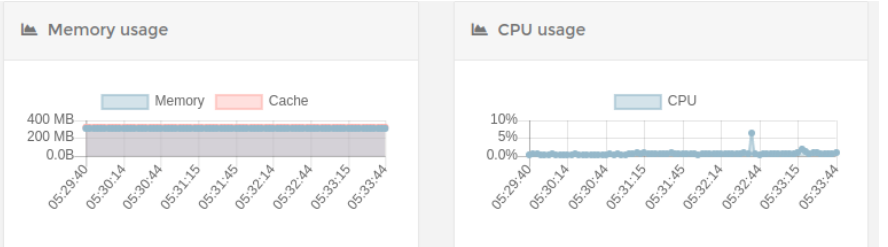
Figure 16. Docker CPU and memory utilization for one instance of mining and replicating the transactions requested during the